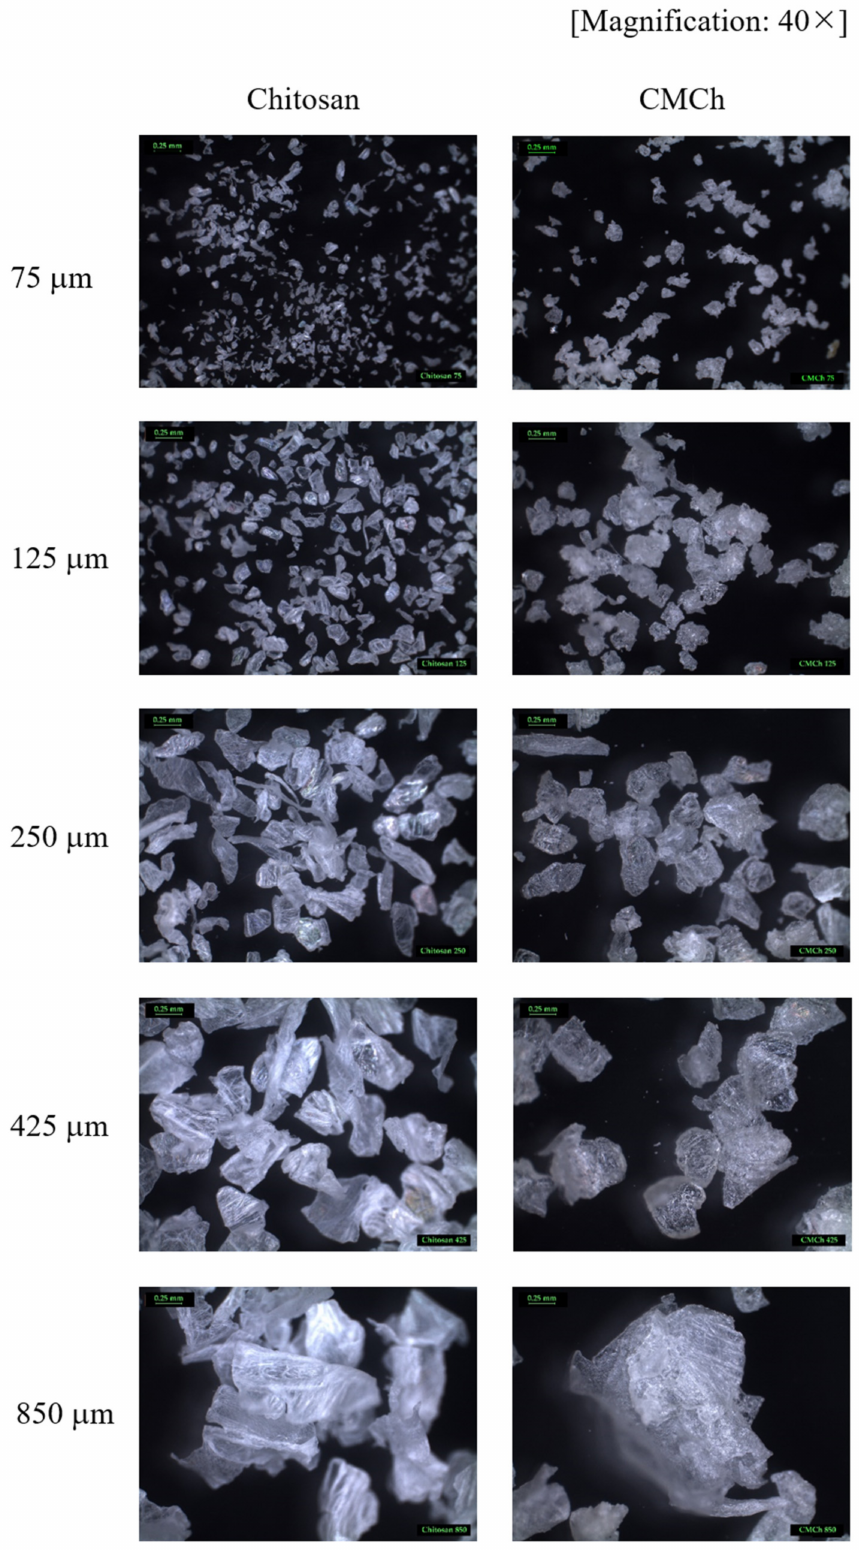
Figure 2. The morphology and physical appearance of chitosan and CMCh powders prepared from chitosan with different particle